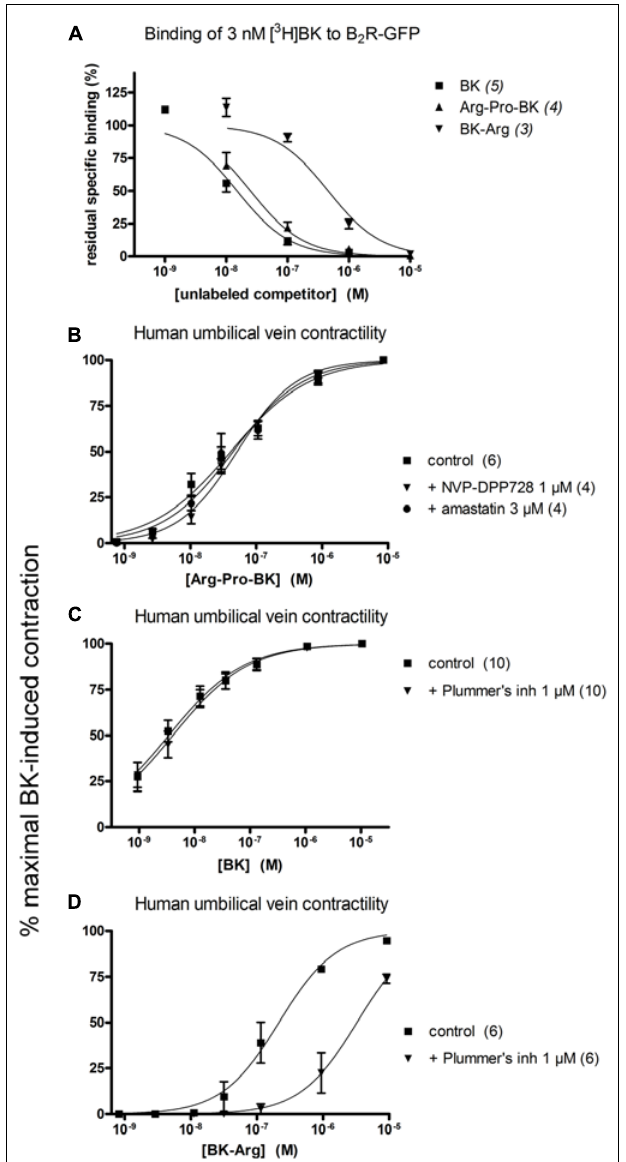
FIGURE 5 | Pharmacology ofArg-Pro-BK, a potential DPP IV substrate, and of BK-Arg, an arginine carboxypeptidase substate. (A) Competition of [ 3 H]BK (3 nM) binding to stably expressed B 2 R-GFP in HEK 293 cells. (B) Cumulative concentration-effect curve for Arg-Pro-BK as modified by the DPP IV inhibitor NVP-DPP728 (1 μ M) or the aminopeptidase inhibitor amastatin (3 μ M). (C) Lack of effect of Plummer’s inhibitor on BK-induced contraction of the human umbilical vein preparation. (D) Cumulative concentration-effect curve for BK-Arg as modified by the same drug. Presentation as in Figures 2 and 3 .